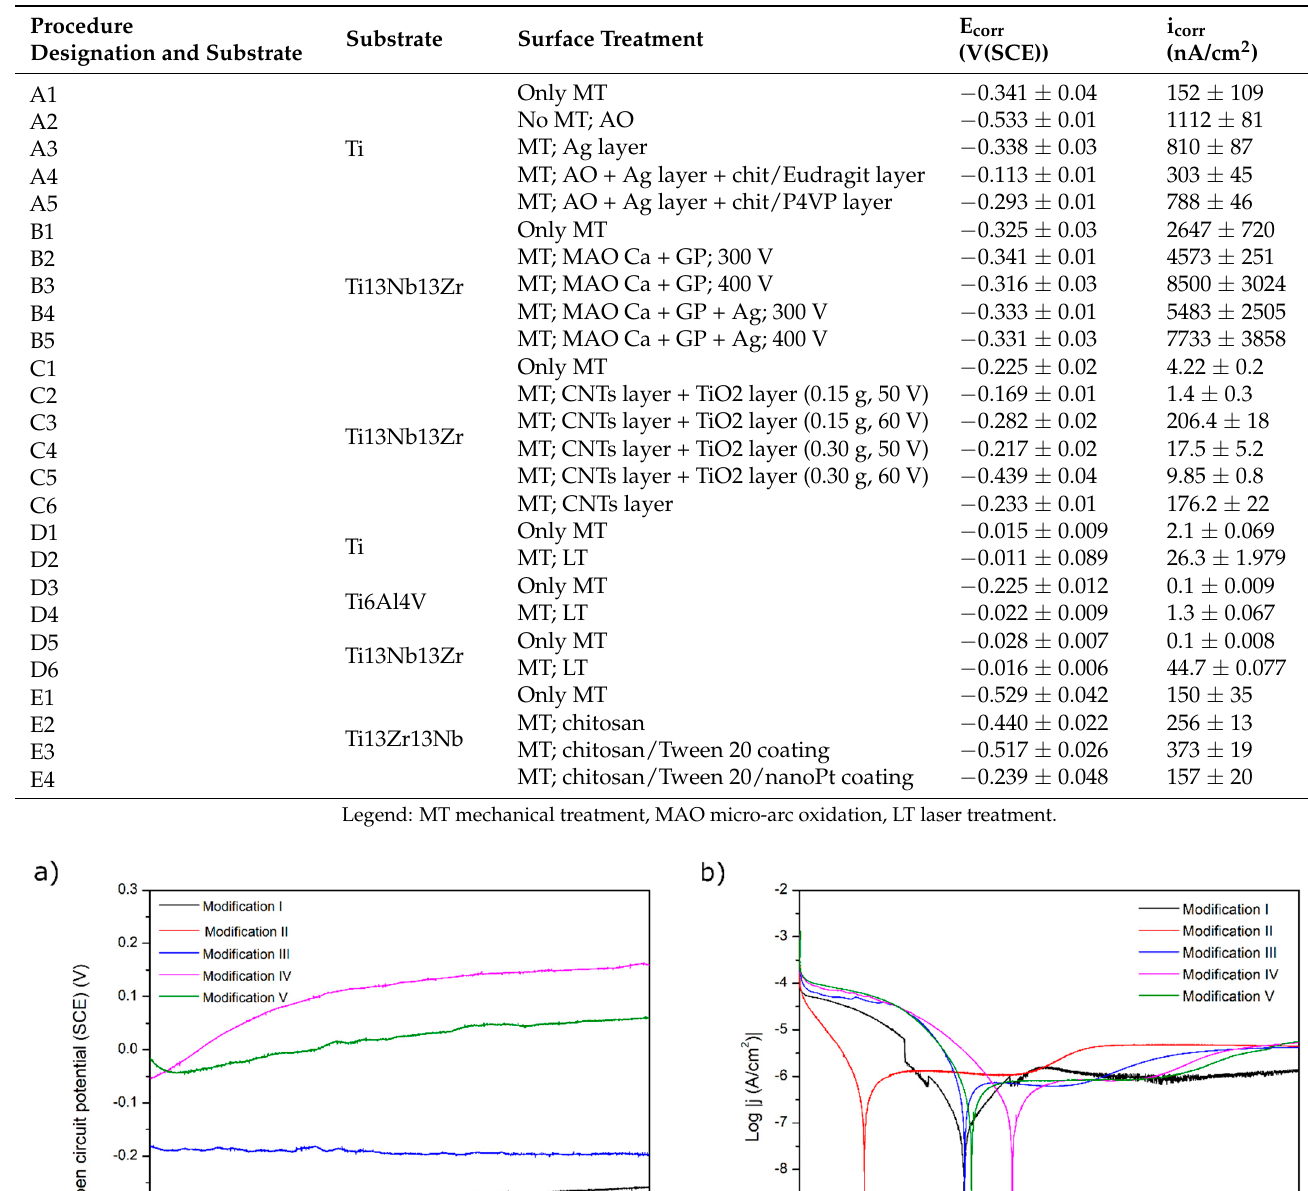
Table 4. Results of corrosion tests.